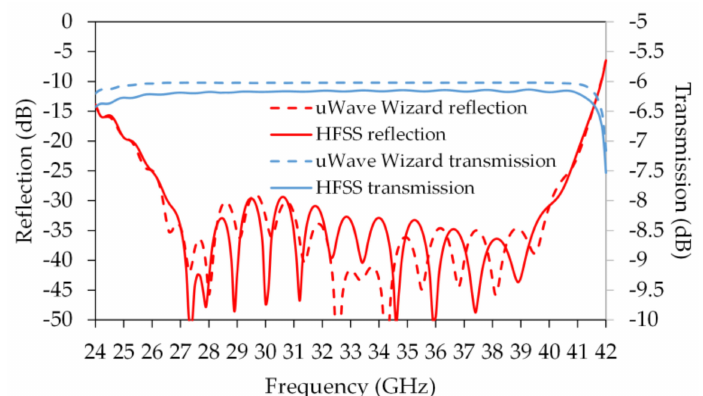
Figure 7. Simulated performance of the whole power divider structure; reflection at common port in red lines and input–output transmission in blue lines. Results from µ Wave Wizard in dashed lines and from HFSS in solid lines. Insertion loss from HFSS obtained with an aluminum electrical conductivity of σ = 3.8 × 10 7 S/m.